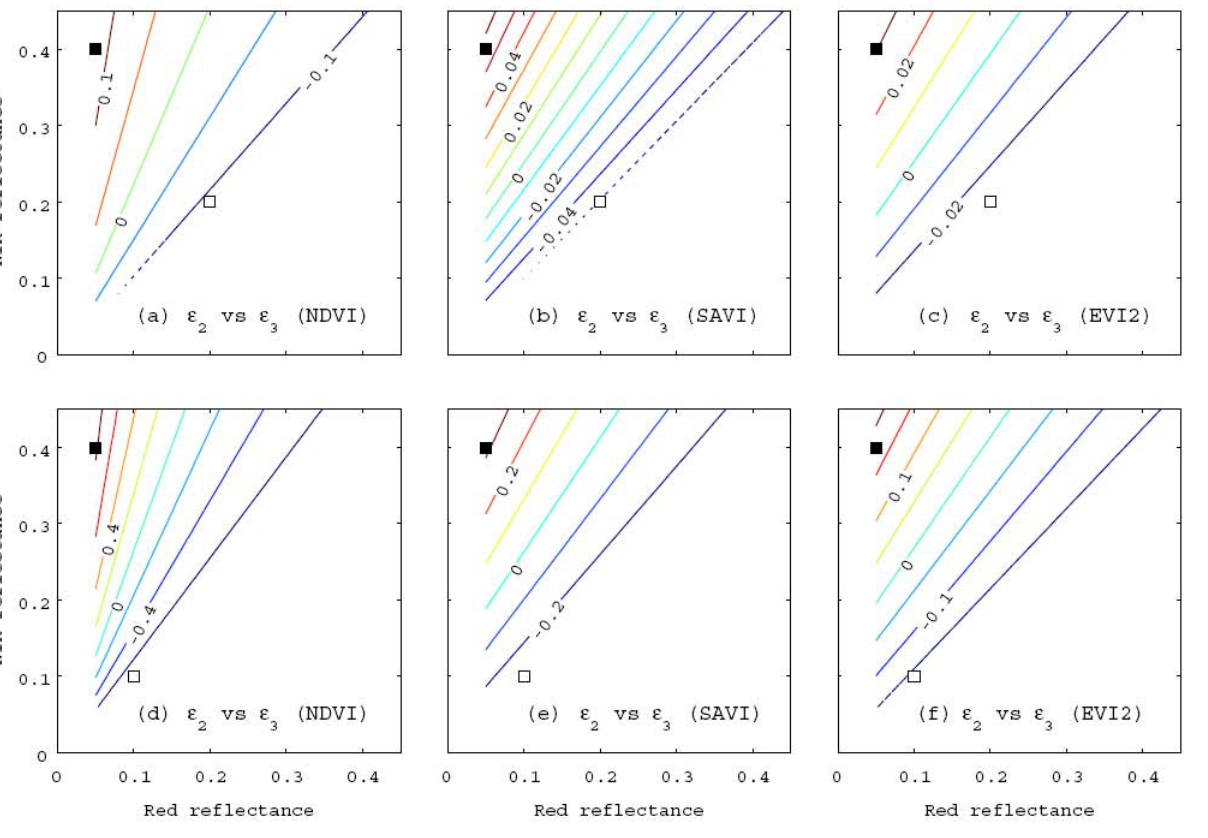
. ( a – c ) 0 -map for the VIs 0